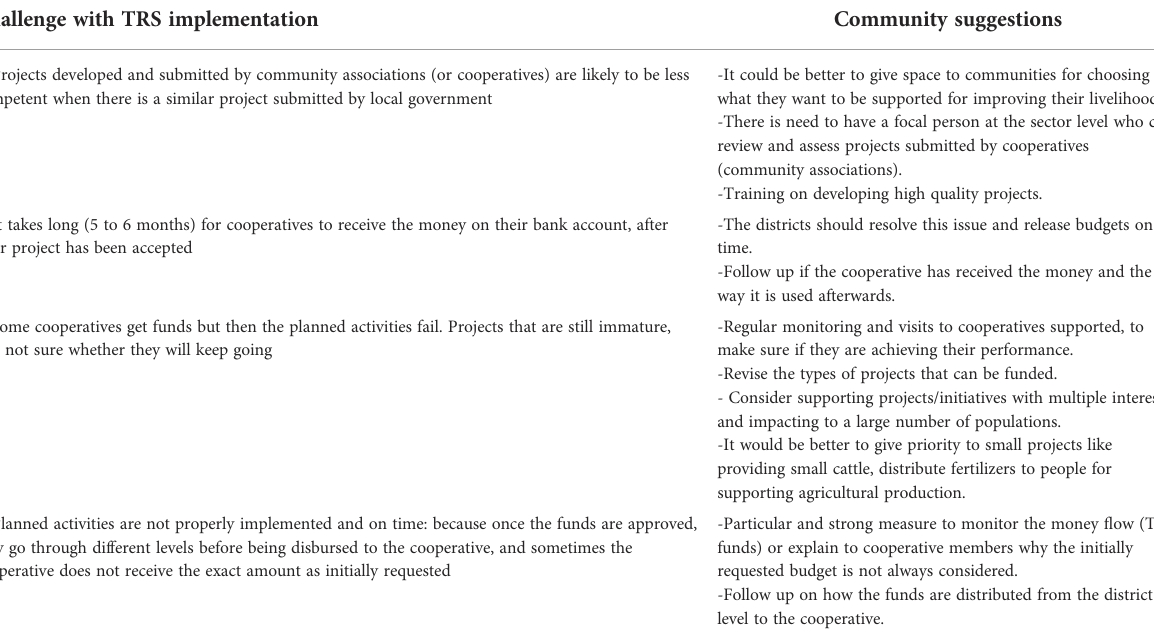
TABLE 6 Major challenges in the implementation of the tourism revenue sharing (TRS) and possible